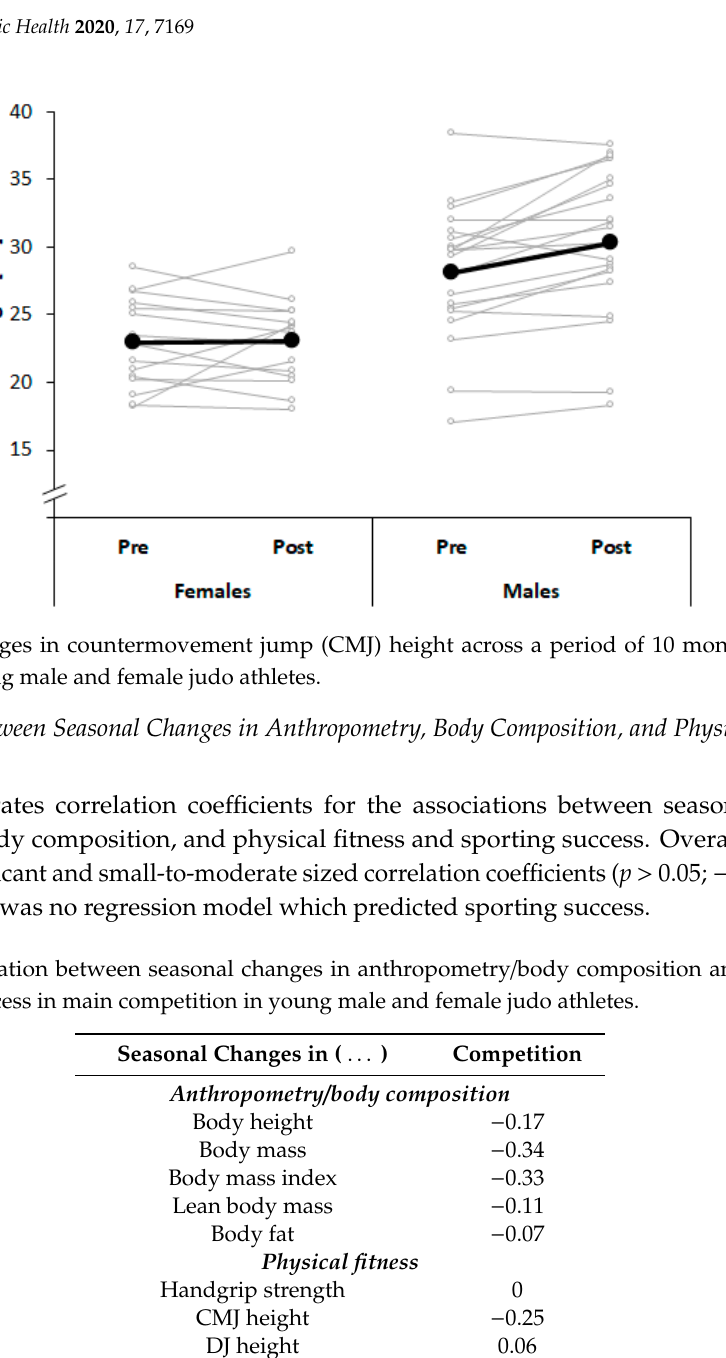
Figure 4. Changes in handgrip strength across a period of 10 months of judo training in young male and female judo athletes.